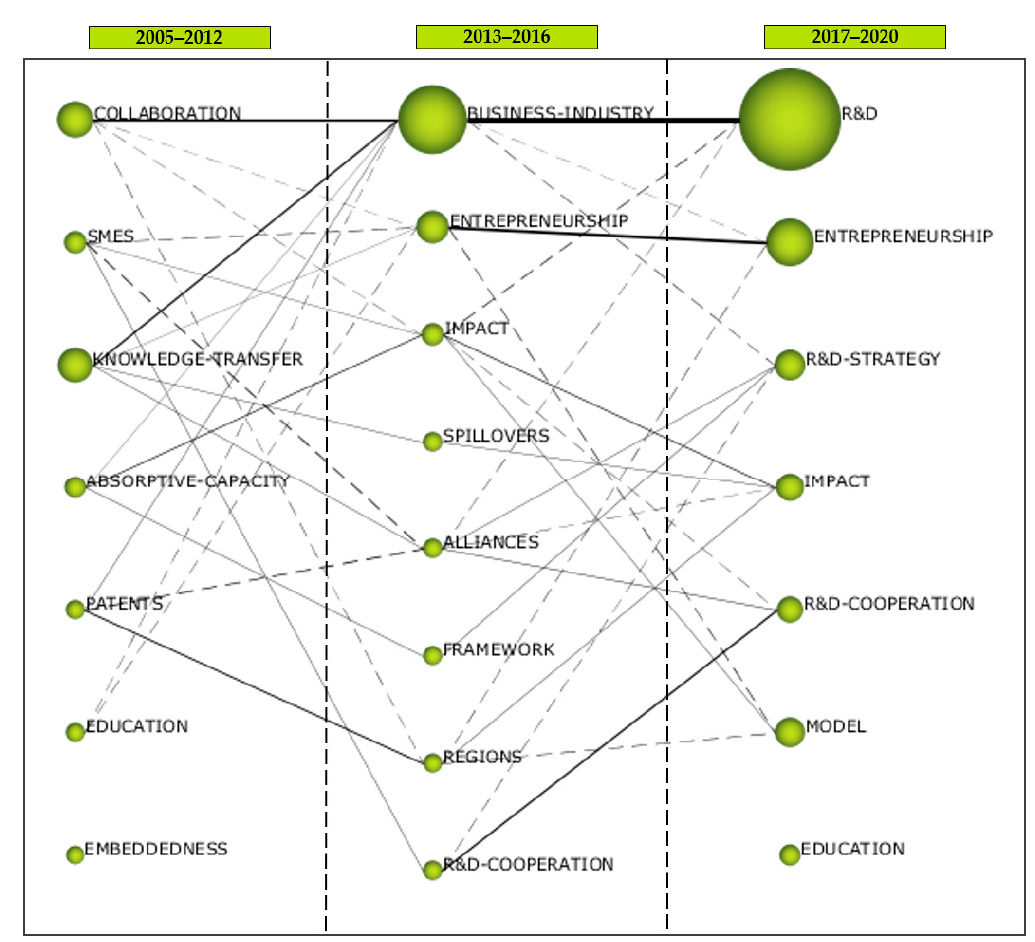
Figure 4. Evolution of the themes of primary documents. Source: Prepared by the authors on the basis of SciMAT data. The size of the sphere is proportional to the number of documents of the theme it represents, in relation to the other themes of the same period. Table 4. Quantitative and qualitative factors of the themes and their evolution.